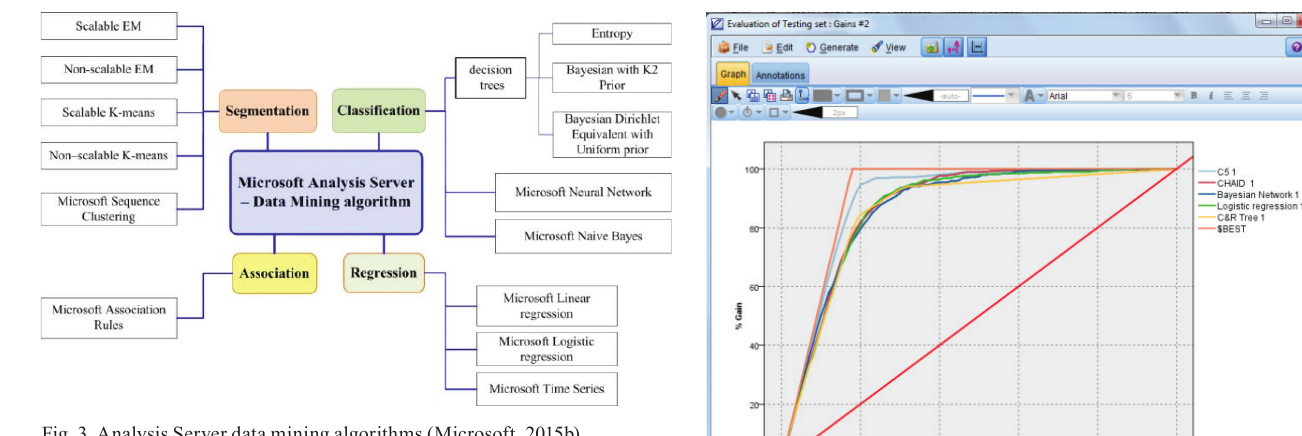
Fig. 3. Analysis Server data mining algorithms (Microsoft, 2015b).